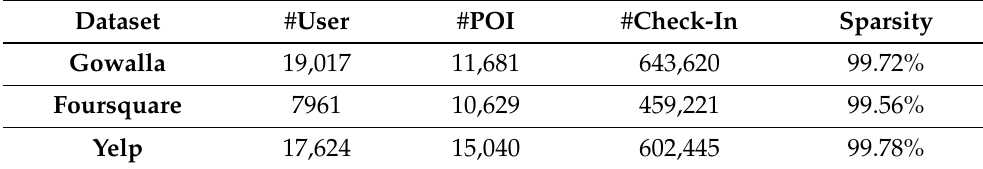
Table 3. The statistics of the used data